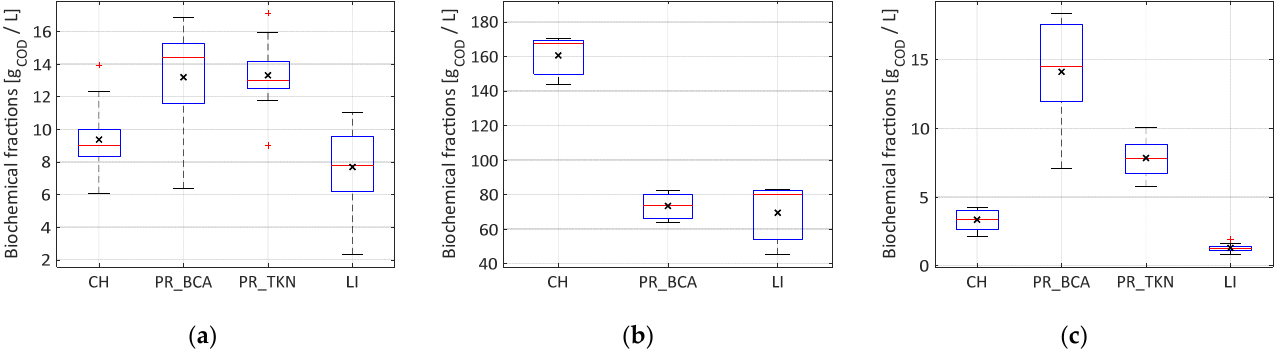
Figure 3. Boxplots of biochemical fractionation for ( a ) waste sludge (n = 9), ( b ) yogurt (n = 3), and ( c ) digestate (n = 9): the black mark is the mean, the red line is the median, and the edges of the box are the 25th and 75th percentiles. The whiskers extend to the most extreme datapoints not to be considered as outliers.